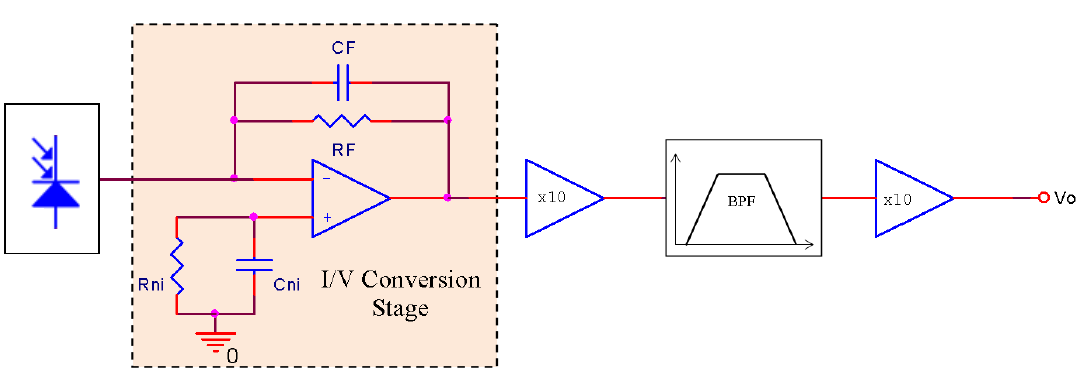
Figure 7. Receiving